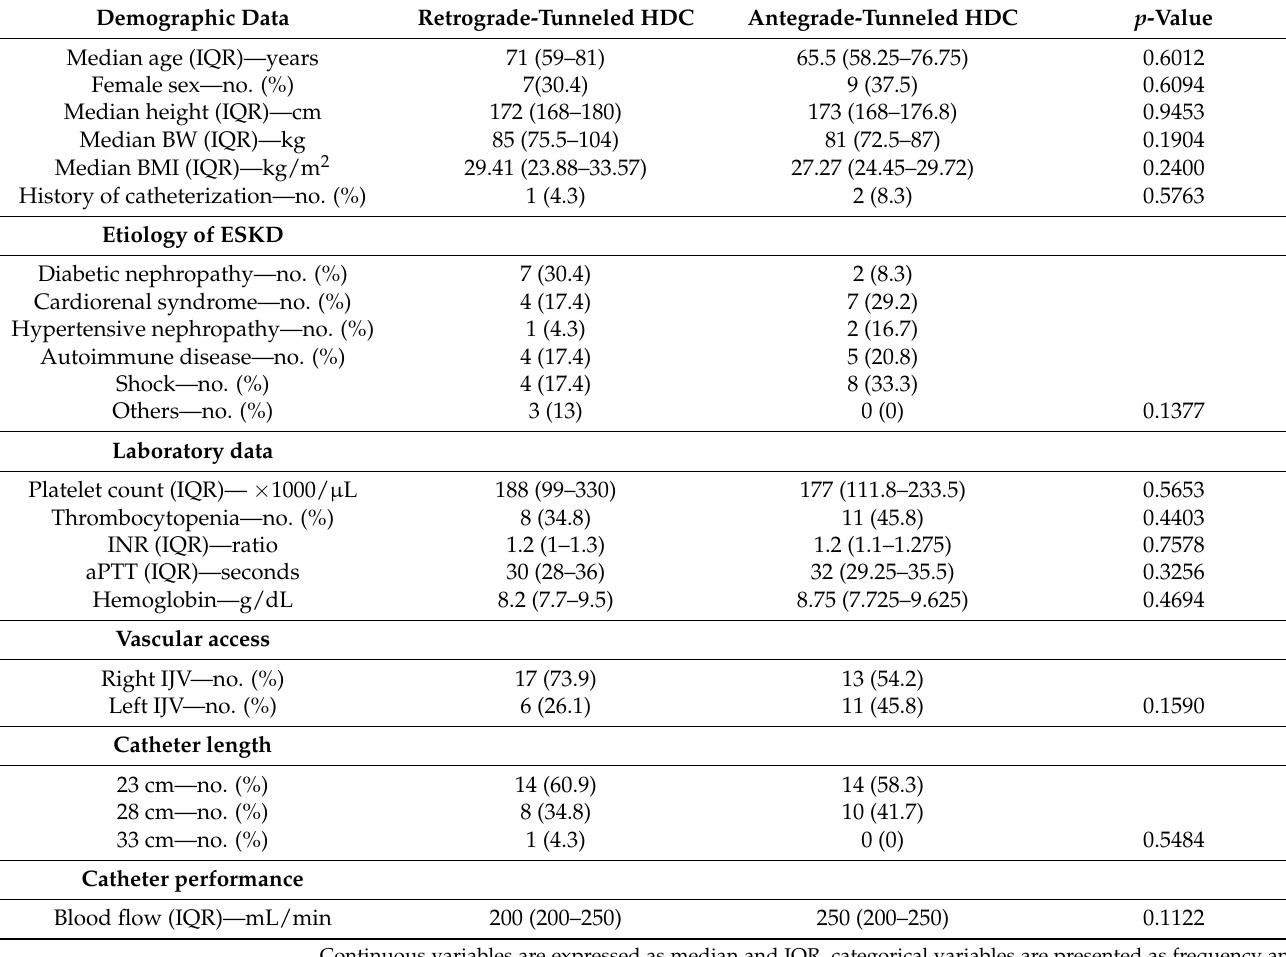
Table 1. Clinical parameters in the total cohort of